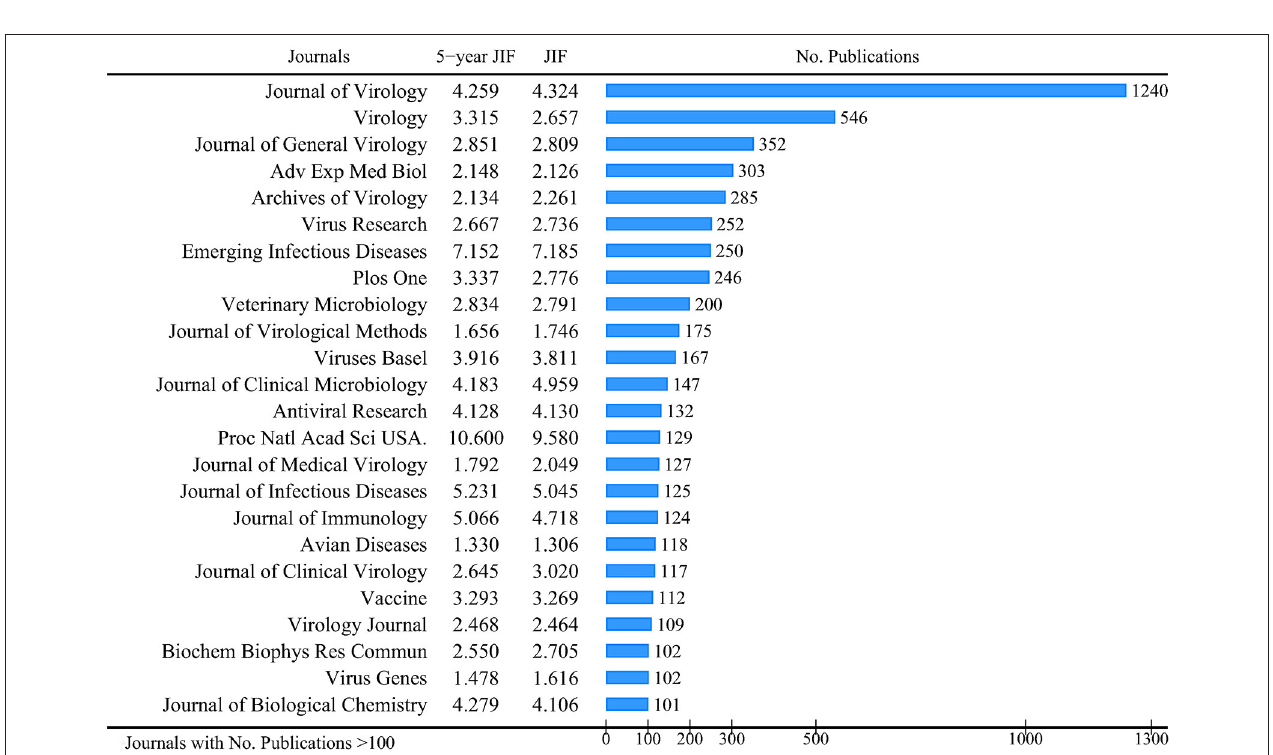
FIGURE 1 | Annual trends of CoV-related publications.